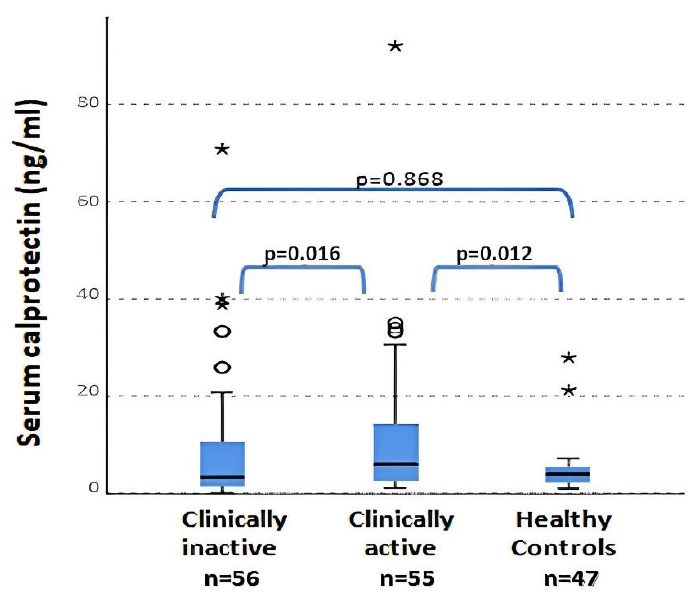
Figure 2. Serum calprotectin levels in active and inactive patients and in controls (ANOVA test). ° = outliers; * = extreme outliers